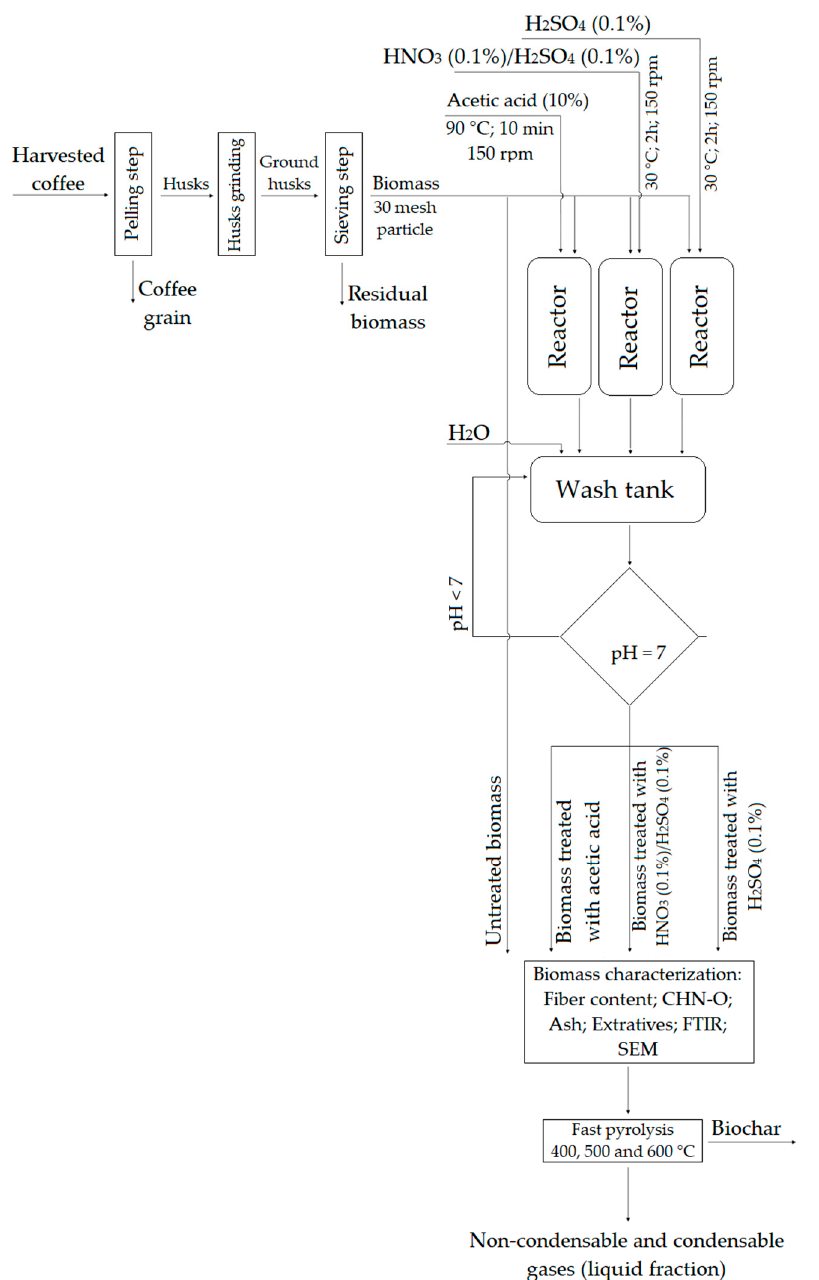
Figure 1. Block diagram of coffee husk pretreatment with different types of acids prior to fast pyrolysis at different temperatures .